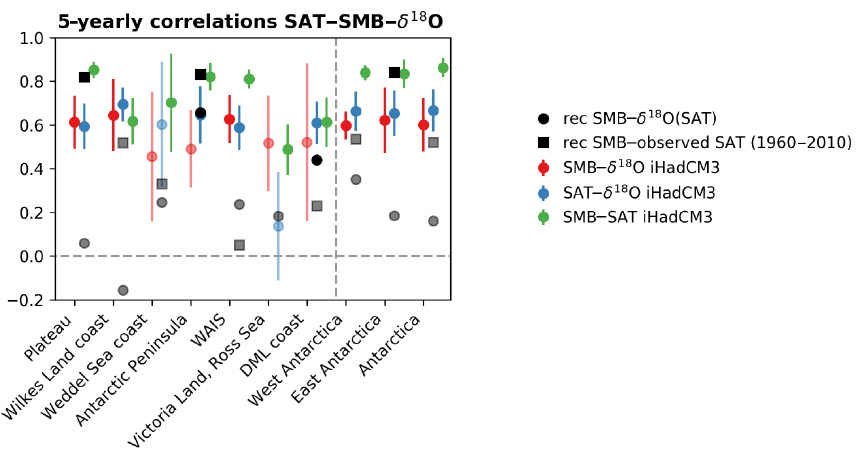
Figure 6. The 5-year correlations between SMB and δ 18 O, surface air temperature and δ 18 O, and SMB and surface air temperature for the seven Antarctic regions over the 1850–1995 period from the iHadCM3 outputs. The error bars correspond to the range (maximum and minimum) of the iHadCM3 simulations while the dot is the mean of the simulation ensemble is shown. In black circles, the correlation between the SMB ice core reconstructions from Thomas et al. (2017) and the δ 18 O of Antarctic ice cores aggregated for the seven Antarctic regions (Stenni et al., 2017a). In black squares, the correlation between the SMB reconstructions from Thomas et al. (2017) and the observed surface air temperatures aggregated for the seven Antarctic regions (Nicolas and Bromwich, 2014a) is shown. This latter dataset only covers the 1960–2010 period (5-year averages). Non-significant correlations ( p value > = 0.05) are shown in